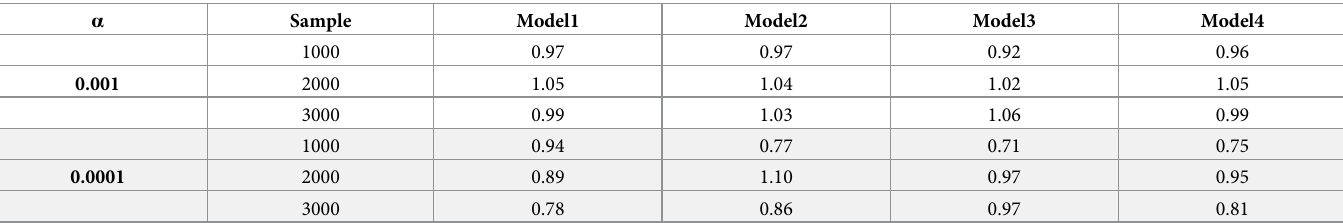
Table 1. The estimated type I error rates divided by the nominal significance levels of the ceCLC method for 20 quantitative phenotypes with 10 6 replications. α Sample